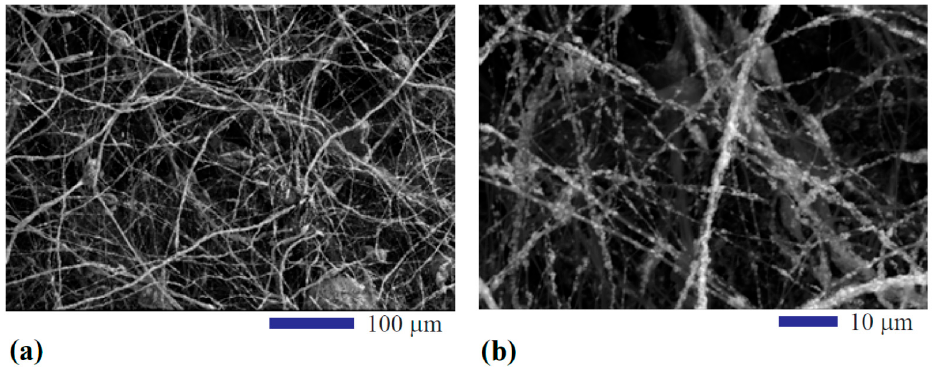
Figure 2. Morphology of the hydrothermal carbonization-coated fiber: ( a ) at lower magnification to show a global view and ( b ) at higher magnification to show activated carbon deposited on the fiber. Spot analysis of the fiber was performed to show the metal transition oxide particle’s composition.